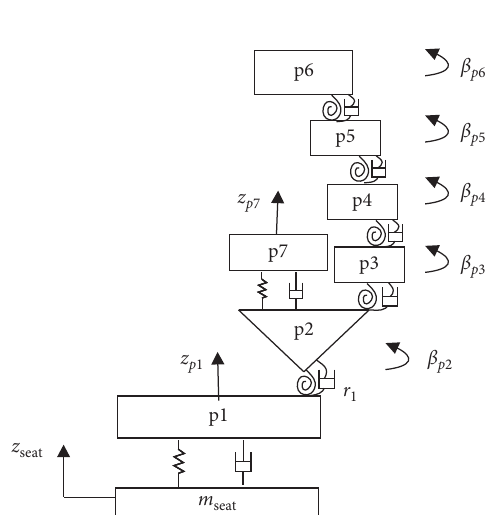
Figure 2: Biodynamic model of the seated human